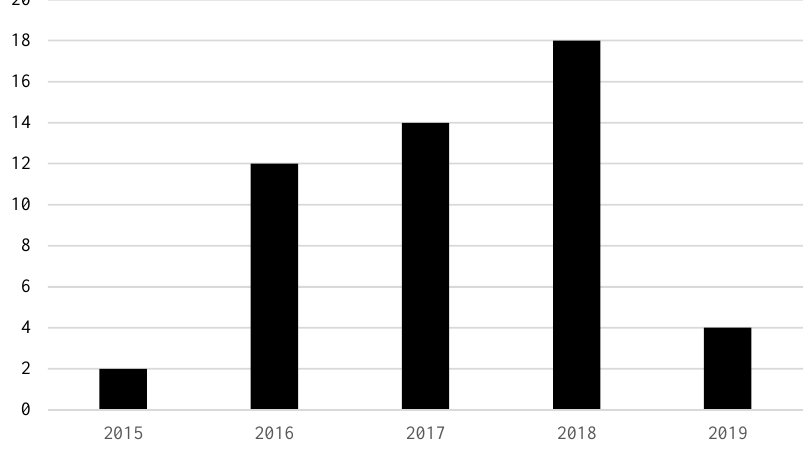
Figure 2. Number of articles selected by years from 2015 to